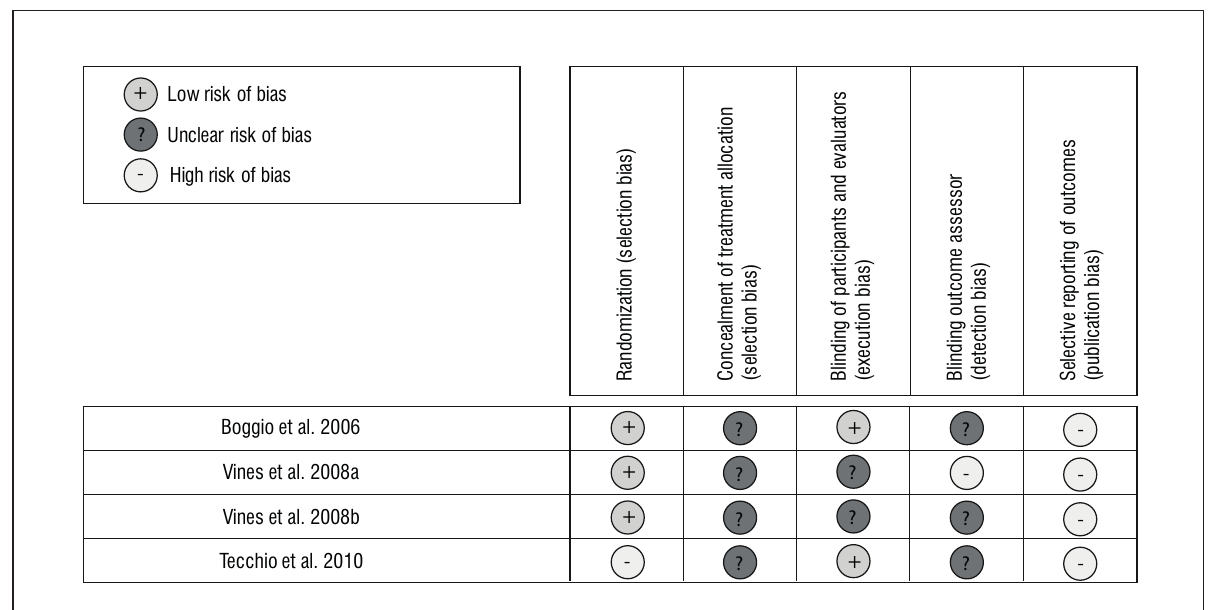
Figure 2 - Risk of bias of the included studies by Cochrane Collaboration’s tool Source: Handbook version 5.1.0